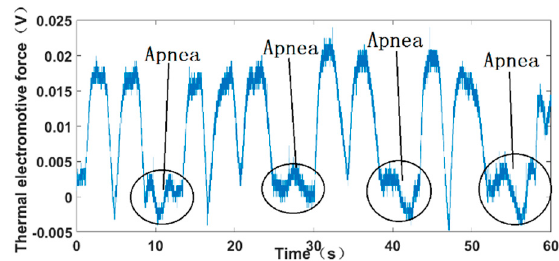
Figure 18. Test results under simulated apnea.